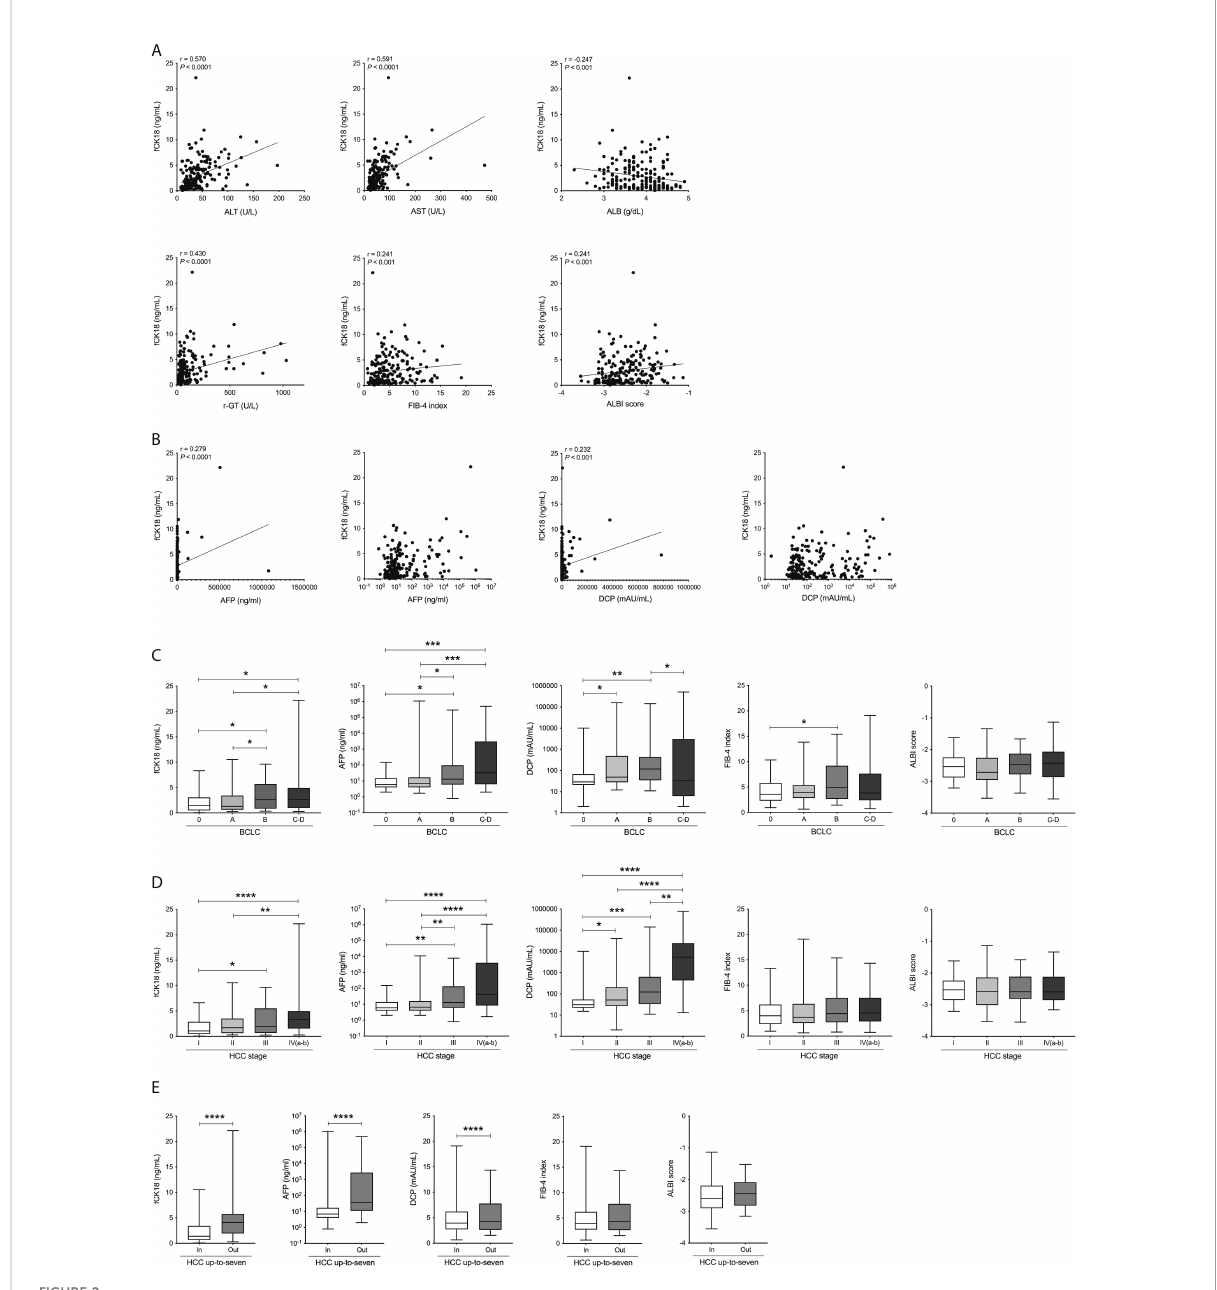
FIGURE 2 Serum fCK18 levels are associated with HCC markers and BCLC stage. (A) Correlation between serum fCK18 levels and ALT, AST, ALB, g -GT, T-Bil, ALBI score and FIB-4 index. (B) Correlation between serum fCK18 levels and HCC markers, such as AFP and DCP, with linear and log axis (C – E) Serum fCK18 levels, FIB-4 index and ALBI score in (C) BCLC stage, (D) HCC stage or (E) in or out of HCC up-to-seven. Values are boxed with minimum/maximum. ****p<0.0001, ***p<0.001, **p<0.01, *p<0.05. ALB, albumin; ALT, alanine aminotransferase; AST, aspartate aminotransferase; g -GT, gamma- glutamyltransferase; T-Bil, total bilirubin; ALBI, albumin-bilirubin; FIB-4, fi brosis-4; fCK18, fragmented cytokeratin 18; AFP, alpha-fetoprotein; DCP, des- gamma-carboxy prothrombin; BCLC, Barcelona Clinic Liver Cancer; HCC, hepatocellular